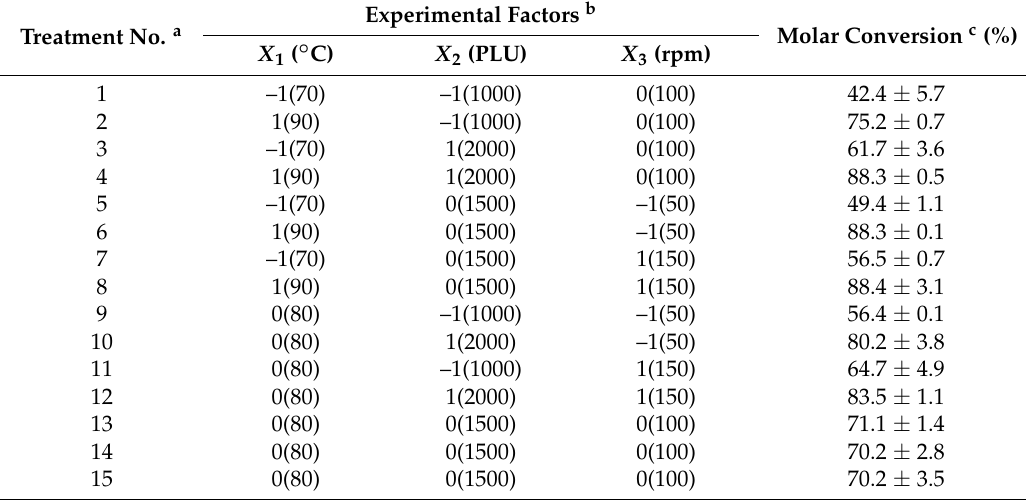
Table 1. Box-Behnken design experiments and observed data of molar